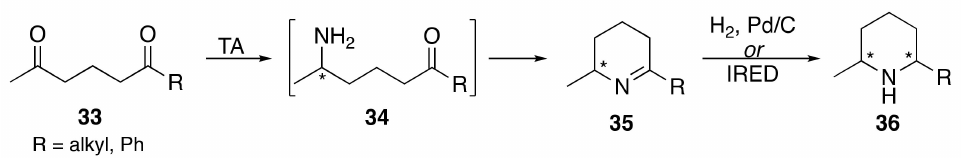
Figure 7. Transaminase-mediated synthesis of piperidine derivatives from